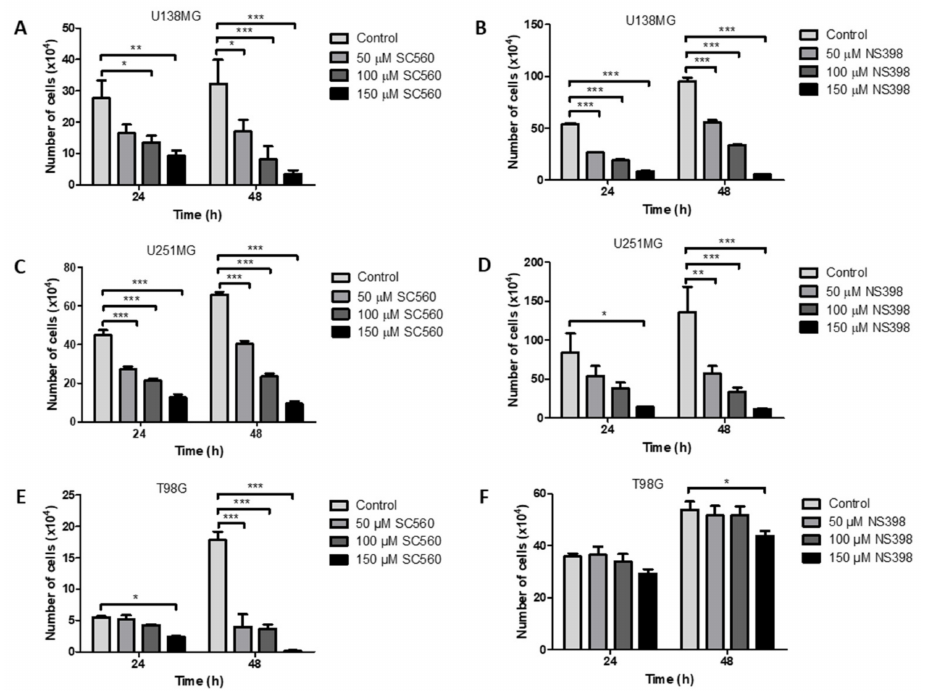
Figure 3. Effects of COX1 inhibitor, SC560, and COX2 inhibitor, NS398, on GBM cells counts. Graphs show the results after 24 or 48 h of treatment with SC560 or NS398. ( A ) SC560 in U138MG cells; ( B ) NS398 in U138MG cells; ( C ) SC560 in U251MG cells; ( D ) NS398 in U251MG cells; ( E ) SC560 in T98G cells; ( F ) NS398 in T98G cells. Data are presented as mean + SEM, n = 4–8. A two-way ANOVA with a Bonferroni post-test was performed. Differences were considered significant at p < 0.05. * = p < 0.05; ** = p < 0.01; *** = p <